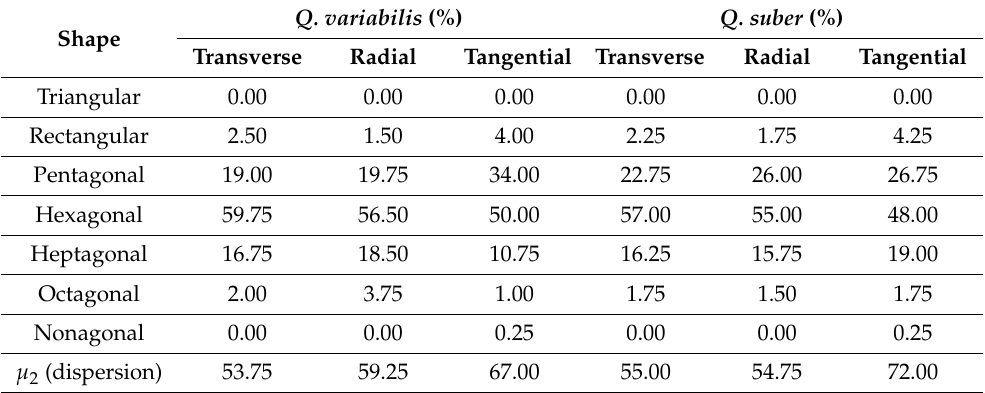
Table 5. Frequency of the edge number in Q. variabilis virgin cork and Q. suber reproduction